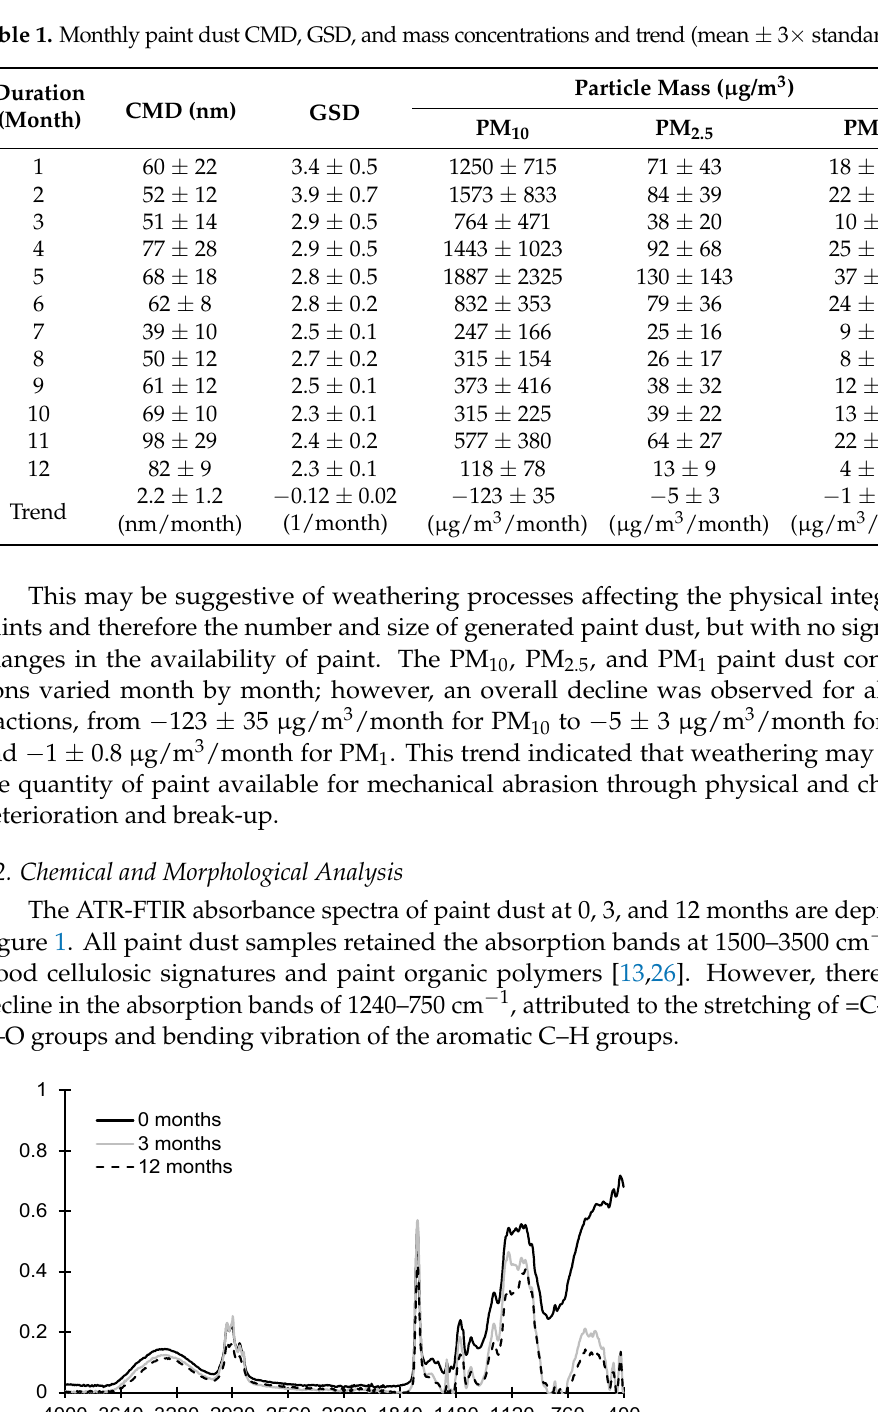
( c ) Figure 2. Backscattering SEM image of paint dust generated by sanding using P120 sandpaper after ( a ) 0, ( b ) 3, and ( c ) 12 months of environmental weathering. 3.3. Weathering Figures 3–5 show the daily variation of meteorological, particulate, and gas pollu- tants with the study period, respectively. The mean daily temperature and relative hu- midity were 18.3 °F and 66%, respectively. There was a total of 123 rain events for a total of 619.3 cm of H 2 O. The winds were blowing from a variable direction, mostly across the southwest–northeast axis, up to 1.77 m/s on average. The mean daily ambient PM 10 and PM 2.5 mass concentrations were 45.8 and 8.8 μ g/m 3 , indicating that a large fraction of am- bient PM 10 was composed of coarse particles. The total sulfate and nitrate concentrations